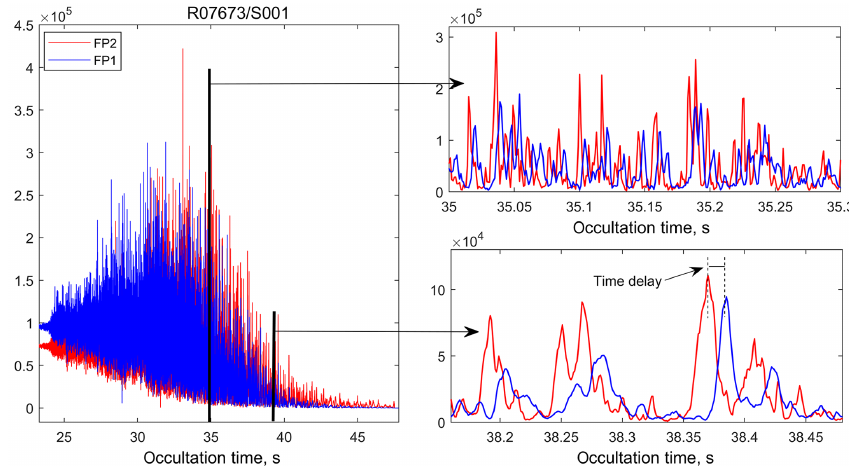
Figure 1. Signals of red (FP2) and blue (FP1) GOMOS photometers.